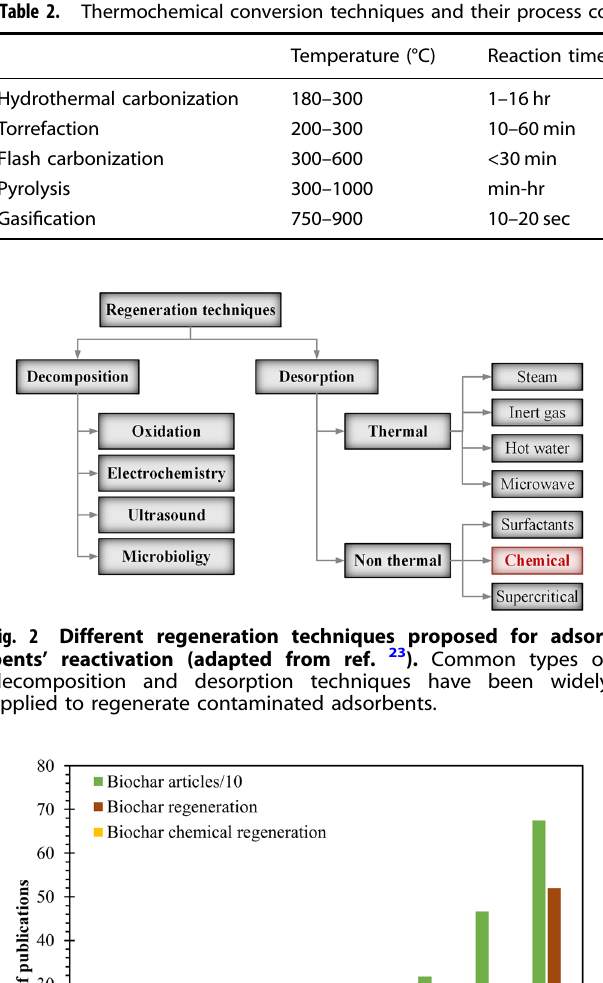
ef fi ciency after each desorption process. Both regeneration and removal data are discussed and reported in tables.